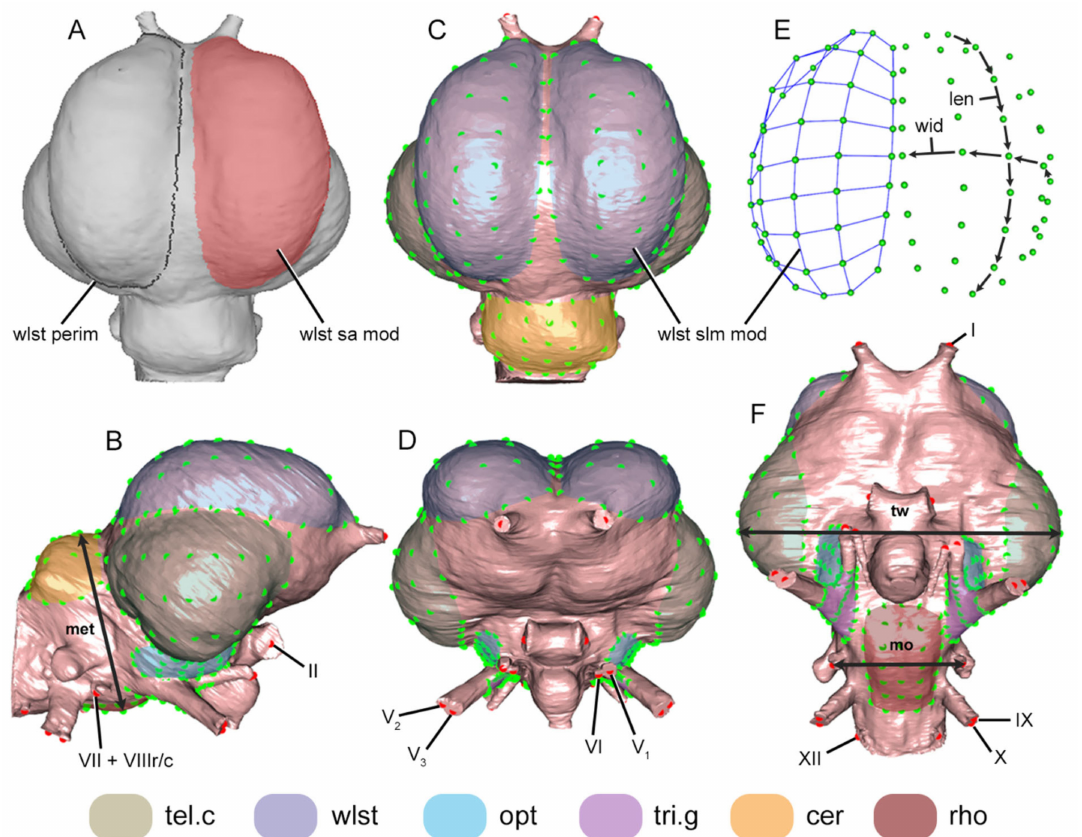
Figure 2. Modular Surface Area ( A ) and Measurement data ( E ), along with landmark modules used to capture endocast shape (see Section 2.6.2, Section 2.6.3 and SI Section S3.2). Brain surface Slm modules (green dots) and innervation Lm module (red dots), are mapped onto the endocast of Dromornis planei (NTM P9464-106), and Slm modules are colour-shaded to facilitate anatomical identification (see also SI Figures S10 and S11). Acquisition of Modular Surface Area data are illustrated by a dorsal endocast ( A ), showing the right side wulst surface area module selected (wlst sa mod–pink), prior to computation of the surface area value for the defined region. The endocast ( A ) also shows the previously defined left side wulst module, circumscribed by a perimeter polyline (wlst perim) for which the surface area value was computed (see Section 2.6.3 above). Measurement values are illustrated by a 3D shape plot ( E ) showing wulst Slm modules (wlst slm mod), left side Slms (green dots) are linked (blue) to provide perspective. Distance (vector) values were calculated between individual Slms forming the modular width ( wid ) and length ( len ) measurements, vector values were then combined to form the total measurement value; Measurements were also calculated between individual Slms for; ( met ), metencephalon (cerebellum + pons) total height; ( tw ), endocast total width; ( mo ), medulla oblongata total width (see Section 2.6.2 above). Views: ( A , C , E ), Dorsal; ( B ), right lateral; ( D ), rostral; ( F ), ventral. Abbreviations: cer, cerebellum; Lm, landmark; mod, module; opt, optic lobe; perim, perimeter; rho, rhombencephalon; sa, surface area; Slm, semilandmark; tel.c, caudal telencephalon; tri.g, trigeminal ganglion; wlst, wulst; I, left olfactory nerve; II, right optic nerve; V 1 , ophthalmic nerve; V 2 , maxillary nerve; V 3 , mandibular nerve; VI, abducent nerve; VII + VIIIr/c, rami of the facial nerve (VII), and the rostral (VIIIr) and caudal (VIIIc) vestibulocochlear nerves; IX, glossopharyngeal nerve; X, vagus nerve; XII, ramus of the hypoglossal (XII) nerve (XIIc in the extant galloanseres ( Section 3.1.6, Figure 4D; SI Figures S10C and S11C). Endocasts are not to scale. [Note: for the modular Slm suite mapped onto the endocast of Leipoa ocellata (MV B12574), see SI Figures S10 and